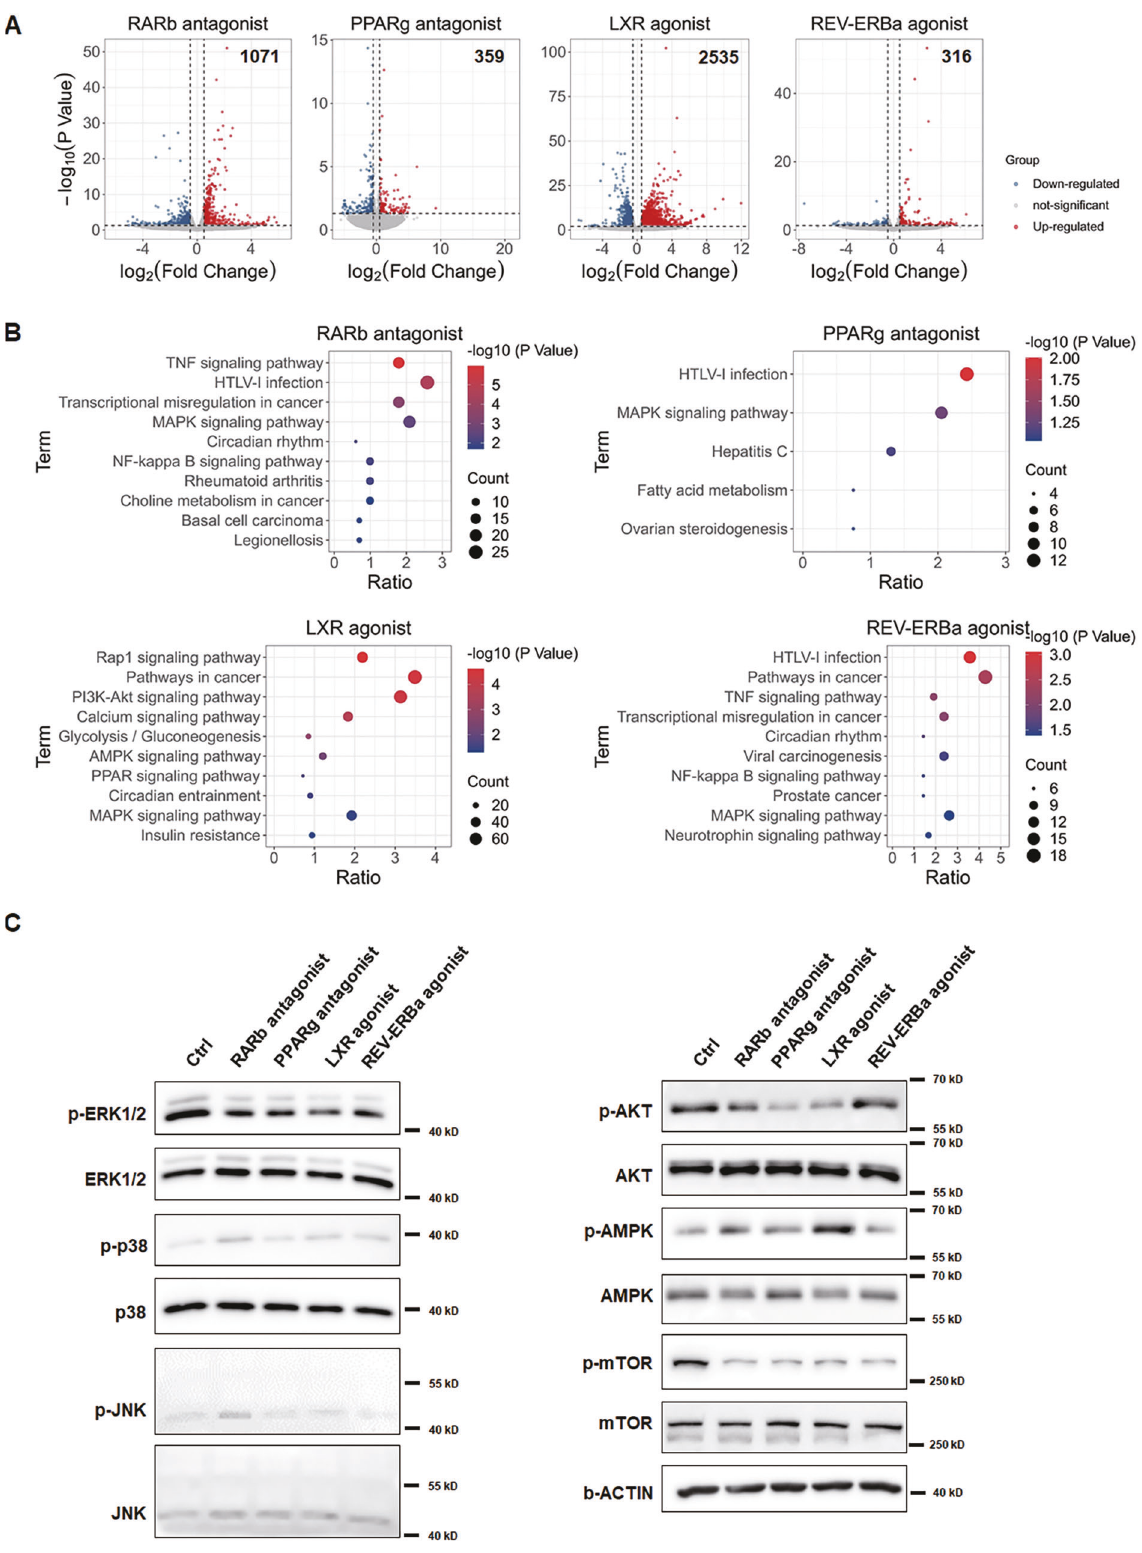
Fig. 5 mTOR acted as a core downstream pathway by which the NR modulators inhibited the growth of osteosarcoma. U2OS cells were treated with the RARb antagonist, PPARg antagonist, LXR agonist and Rev-Erba agonist at 10 μ M for 24 h. The total RNA of cells was extracted for RNA-seq analysis, and the DEGs of each group were identi fi ed ( n = 3). A Volcano plots show all the genes that were statistically upregulated or downregulated and the number of DEGs in each group. B Functional enrichment analysis was performed to identify signi fi cantly enriched KEGG pathways in each group. C Immunoblots show the levels of phosphorylated ERK1/2, p38, JNK, AKT, AMPK and mTOR in cells.